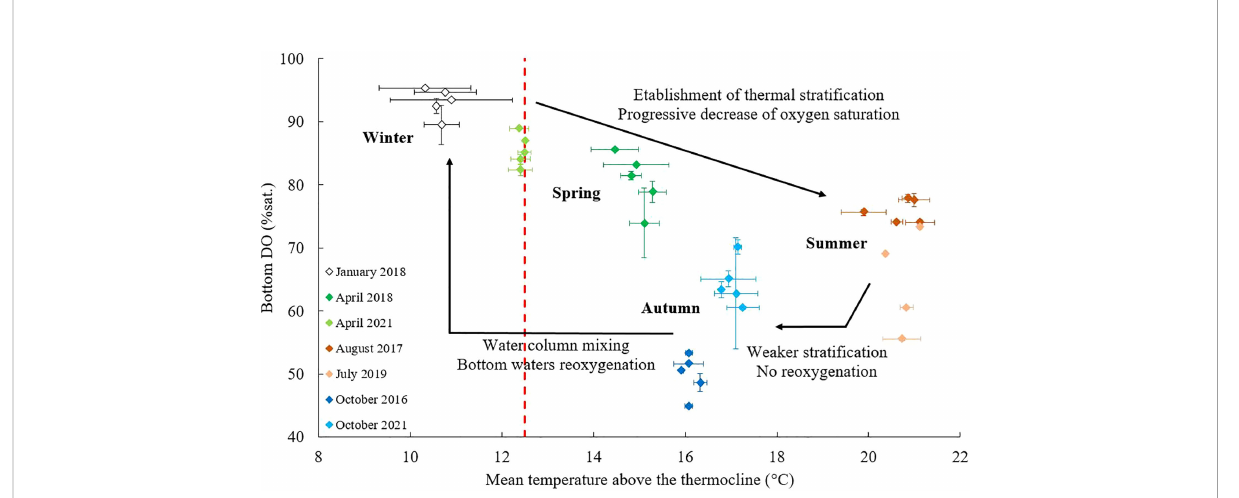
FIGURE 3 Mean dissolved oxygen (DO) saturation in bottom waters (based on the 5 meters above the bottom) against the mean temperature above the thermocline for each cruise and stations 1, 2, 3, 8 and 4. When several pro fi les were available, DO saturations and temperatures of the several pro fi les were averaged. The red dash line represents the threshold of 12.5°C above which the thermal strati fi cation